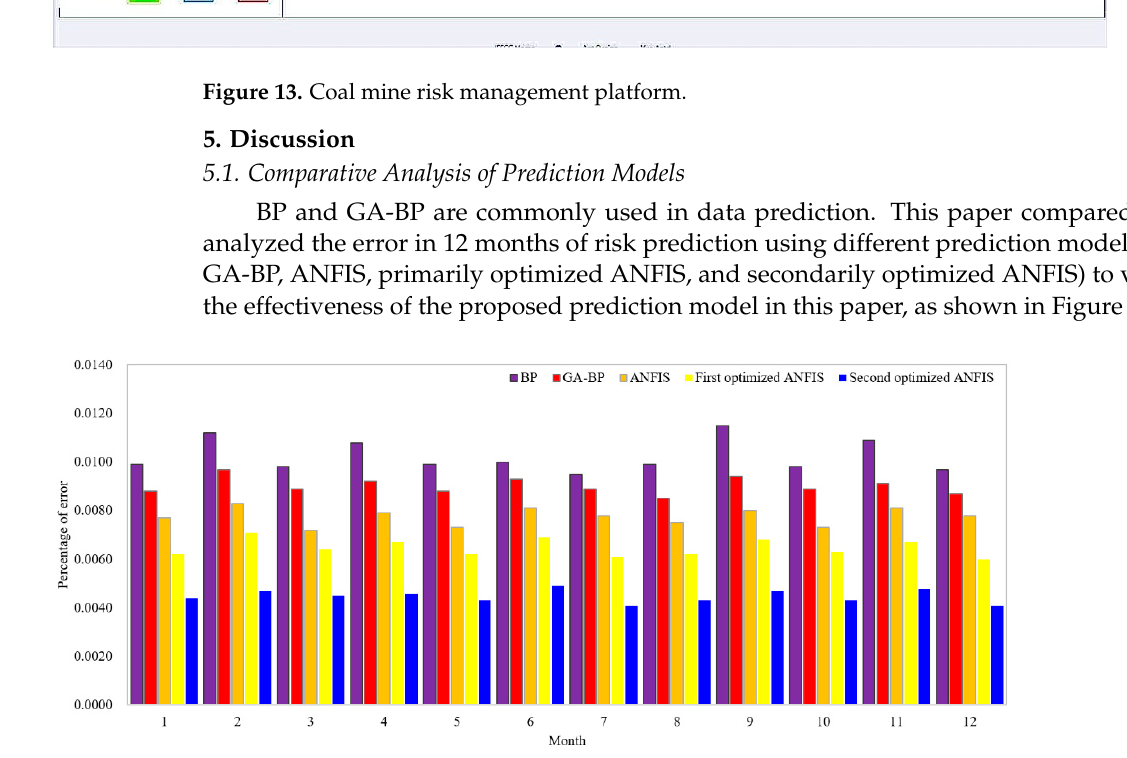
Figure 14. Comparative analysis of prediction error rate.